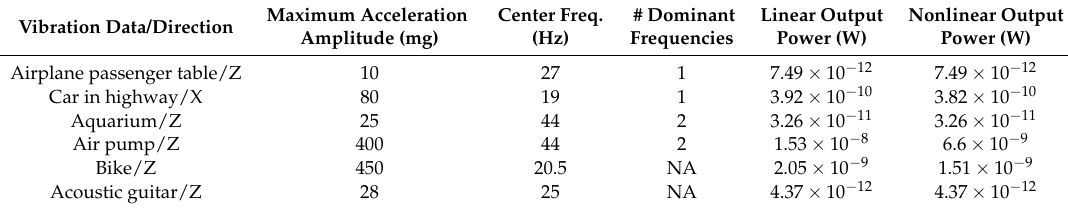
Table 2. Simulation results of output power of the linear and nonlinear harvesters at resonant frequency. Maximum Acceleration Center Vibration Data/Direction